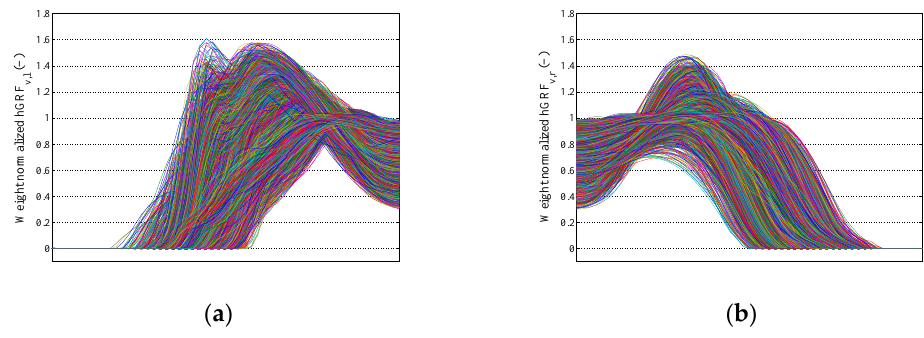
Figure 2. Overlaid plot of ℎ(cid:1833)(cid:1844)(cid:1832) (cid:3049),(cid:3039) ((cid:1872)) ( a ) and ℎ(cid:1833)(cid:1844)(cid:1832) (cid:3049),(cid:3045) ((cid:1872)) ( b ) signals.